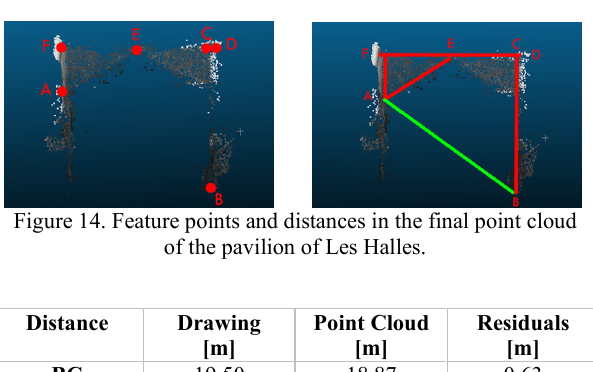
Figure 13. Original drawing of Les Halles by Baltard.